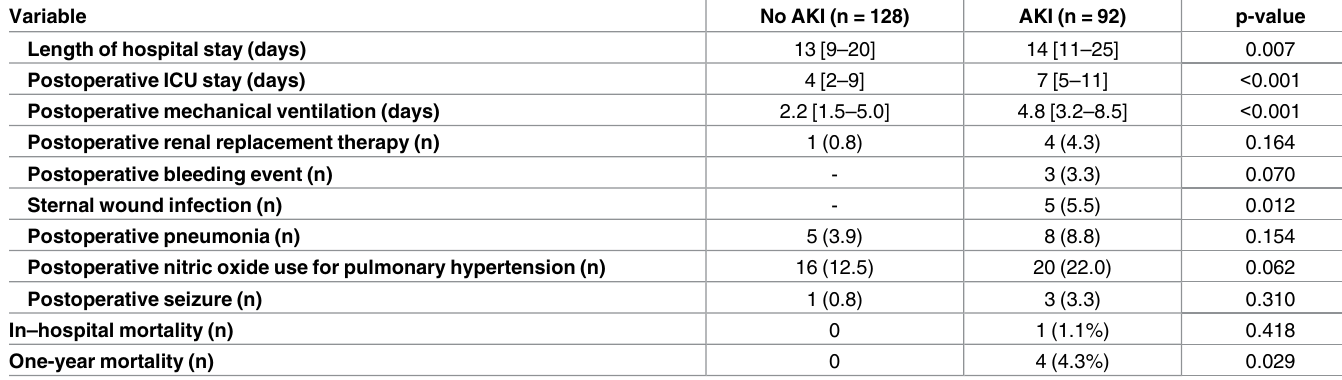
Table 2. Comparison of clinical outcomes between patients with and without postoperative acute kidney injury.